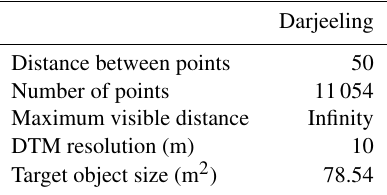
Table 1. Summary of the specific settings to calculate SA maps for each study